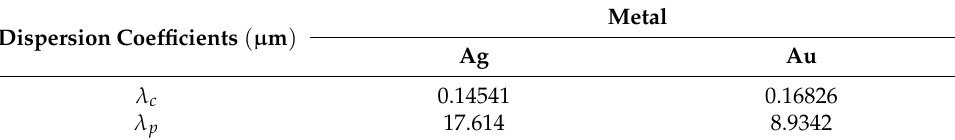
Table 1. Material properties of gold and